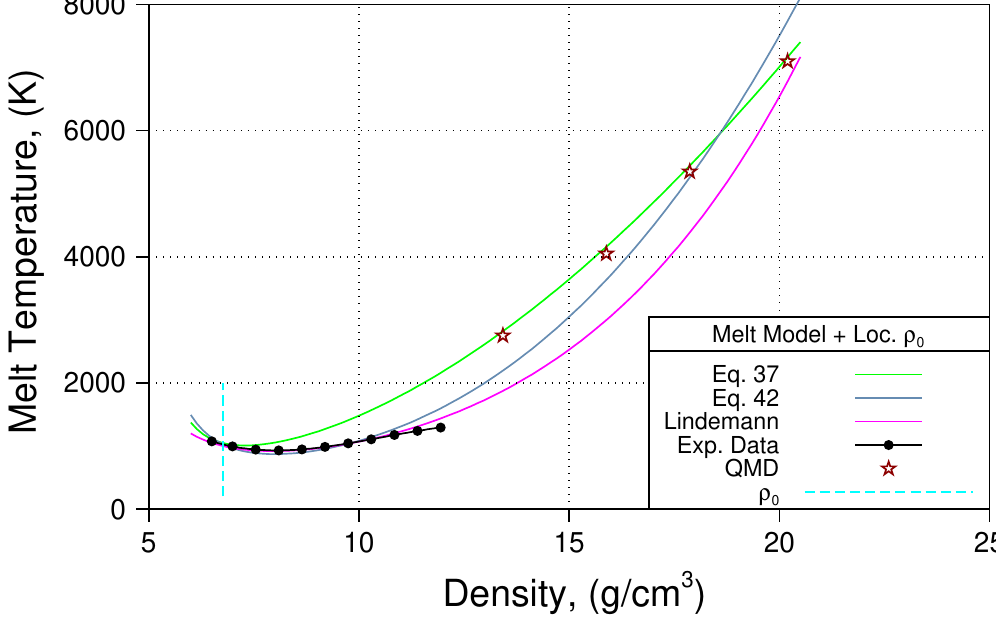
Figure 3. Melt calculated using 5-term Grüneisen added to what was presented in Figure